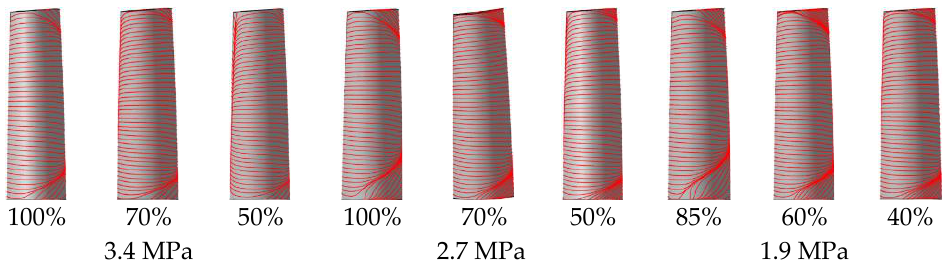
Figure 6. Limiting streamlines on the M-S surface at different loads and back pressures (penultimate stage blade) .